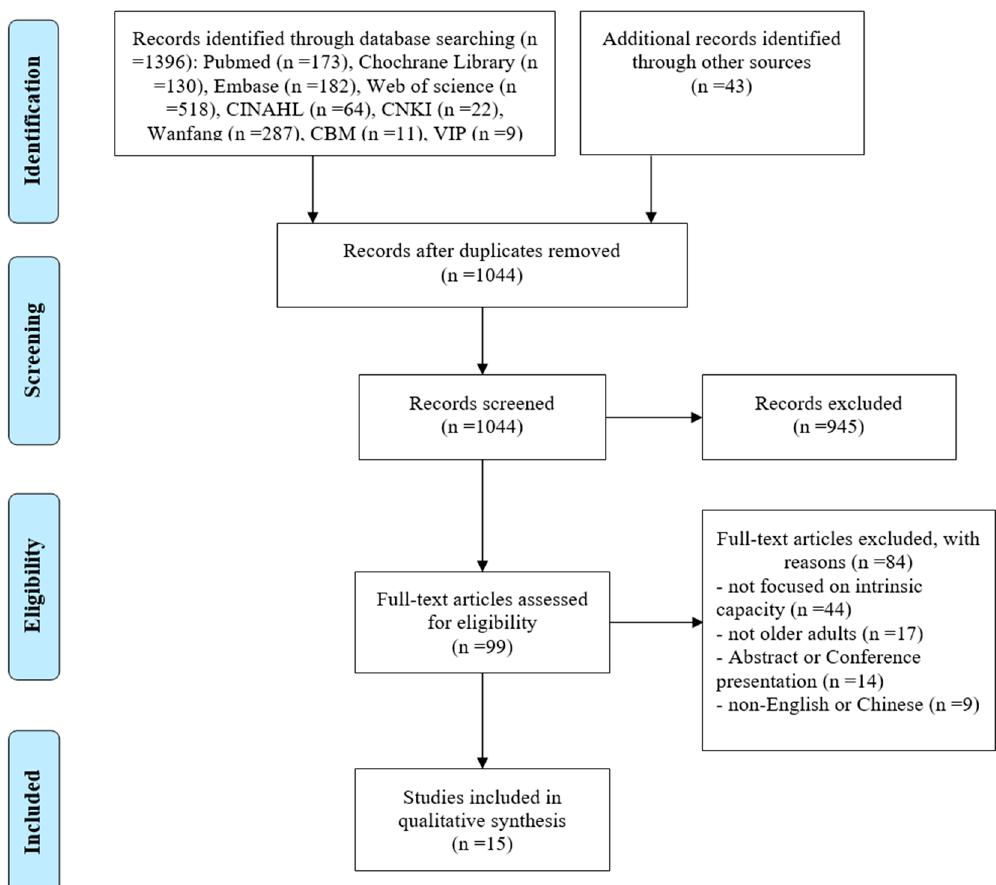
Figure 1. Flow chart of study selection.